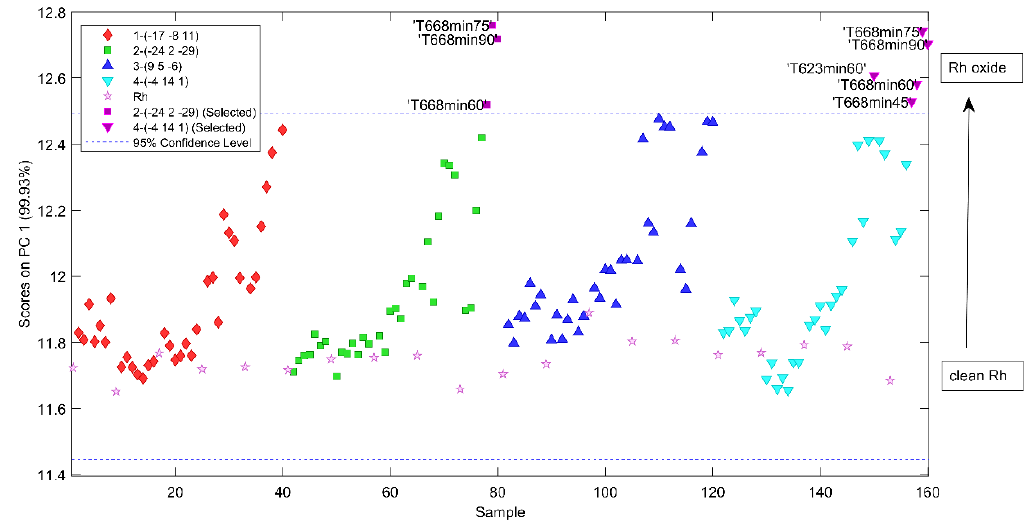
Figure 3. Plot of scores in the PC1 direction as calculated for four polycrystalline rhodium crystallites. The spectra out of the 95% confidence limit were selected.